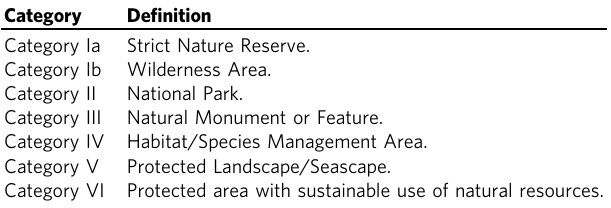
Table 1 Description of International Union for Conservation of Nature (IUCN) Protected Area Management